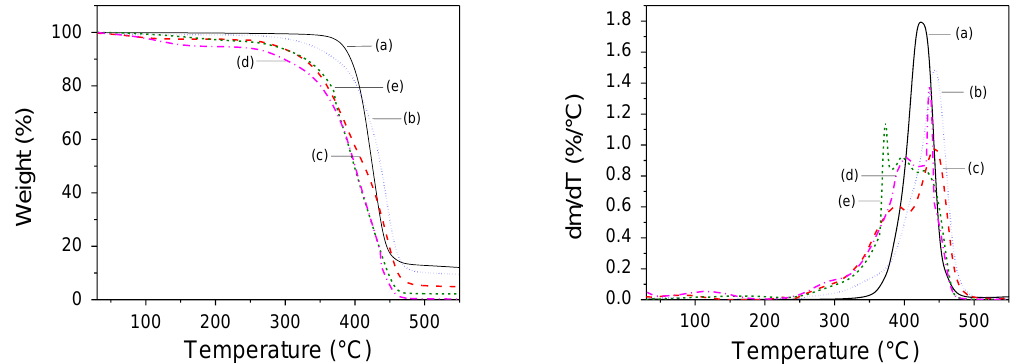
Figure 2. Weight loss and 1st derivate curves of ( a ) unmodified PET, ( b ) UV PET 95:5:0.5 (67% hydrogel), ( c ) UV PET 100:0:0.5 (96% hydrogel), ( d ) UV poly(HEMA-co-PEGMA) hydrogel, and ( e ) UV PHEMA hydrogel.